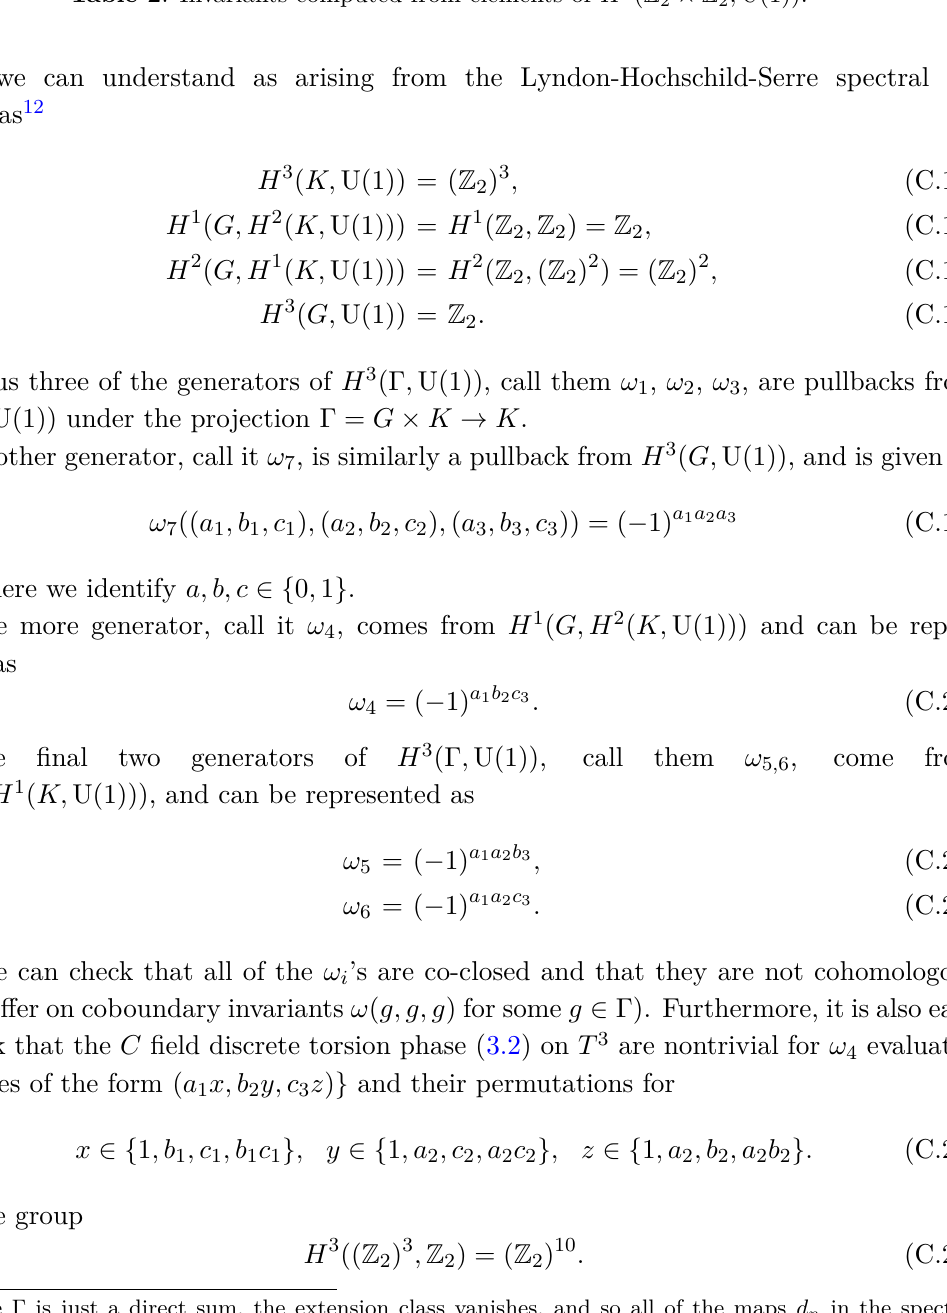
Table 2 . Invariants computed from elements of H 4 ( Z 2 × Z 2 , U(1))